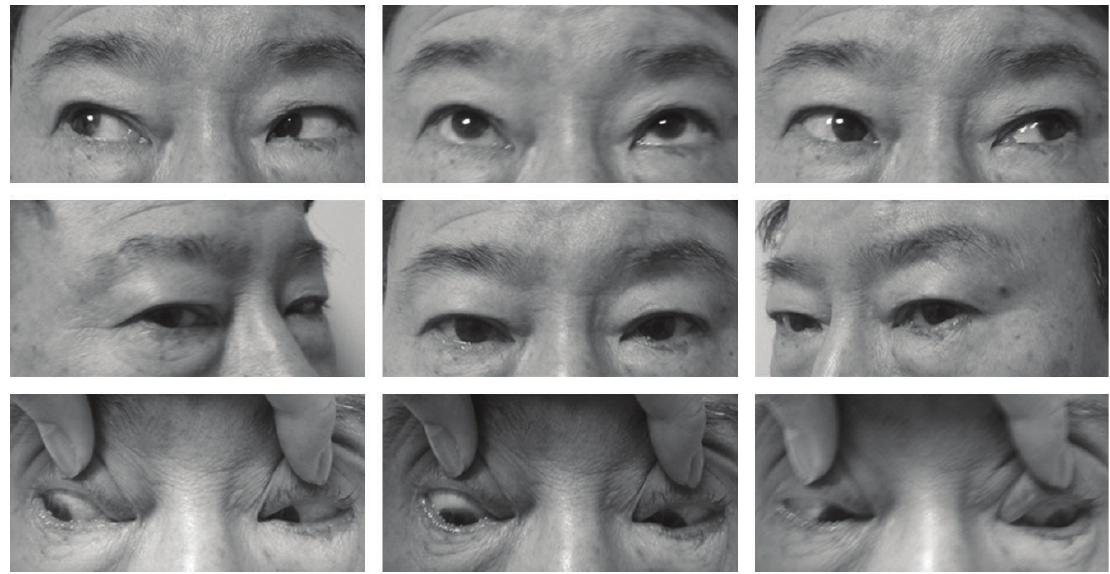
Figure 1: A 9-gaze photography shows esodeviation. No abduction deficit is noted.